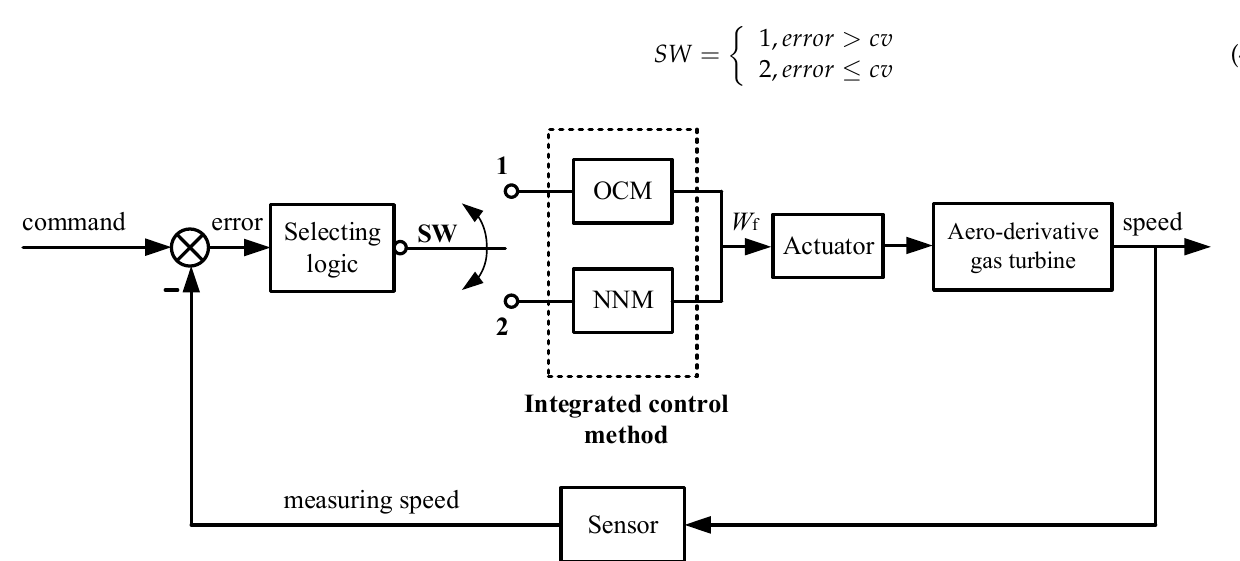
Figure 6. The integrated control method of aero-derivative gas turbine.